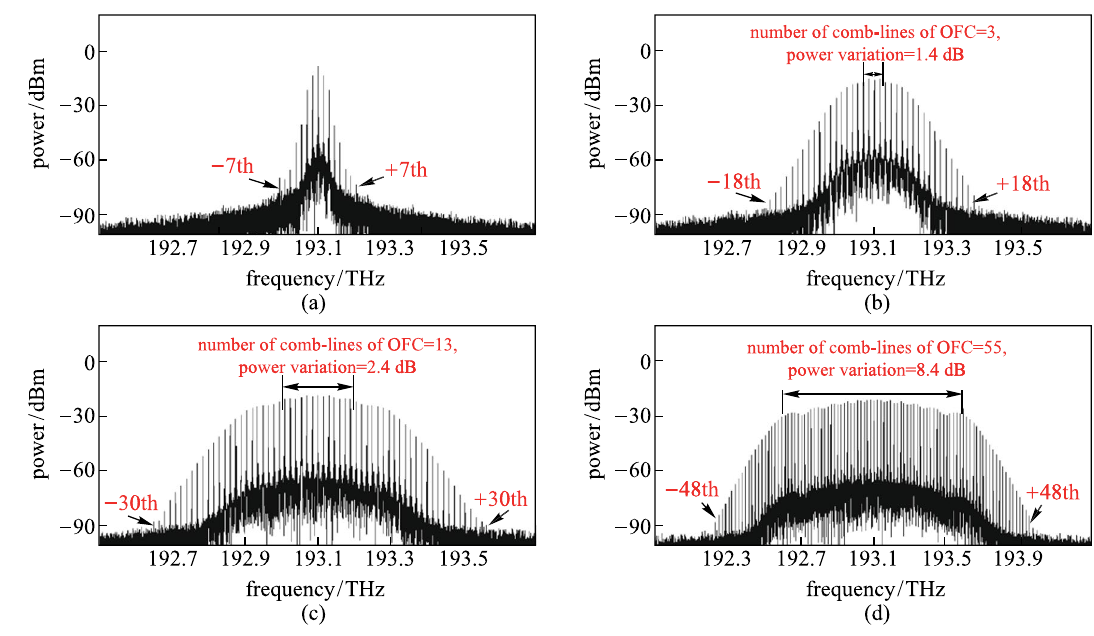
Fig. 4 Influence of the chirp factor of EAM on the optical spectrum of the OFC. Chirp factor of a 0, b 4, c 8, d 16 are